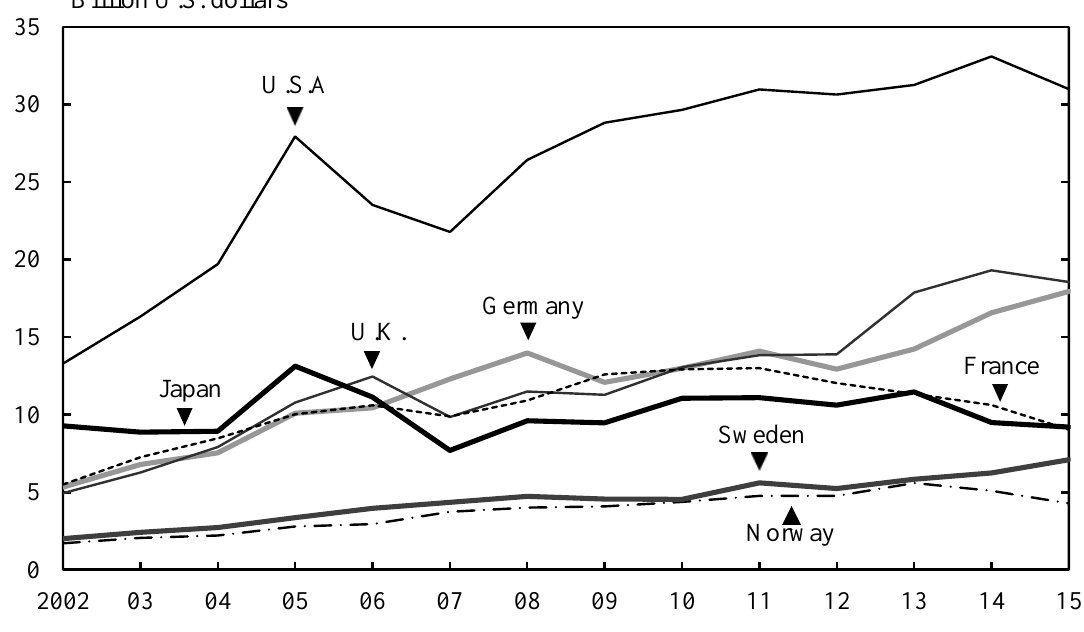
Figure 11.6 Trends in ODA by Country